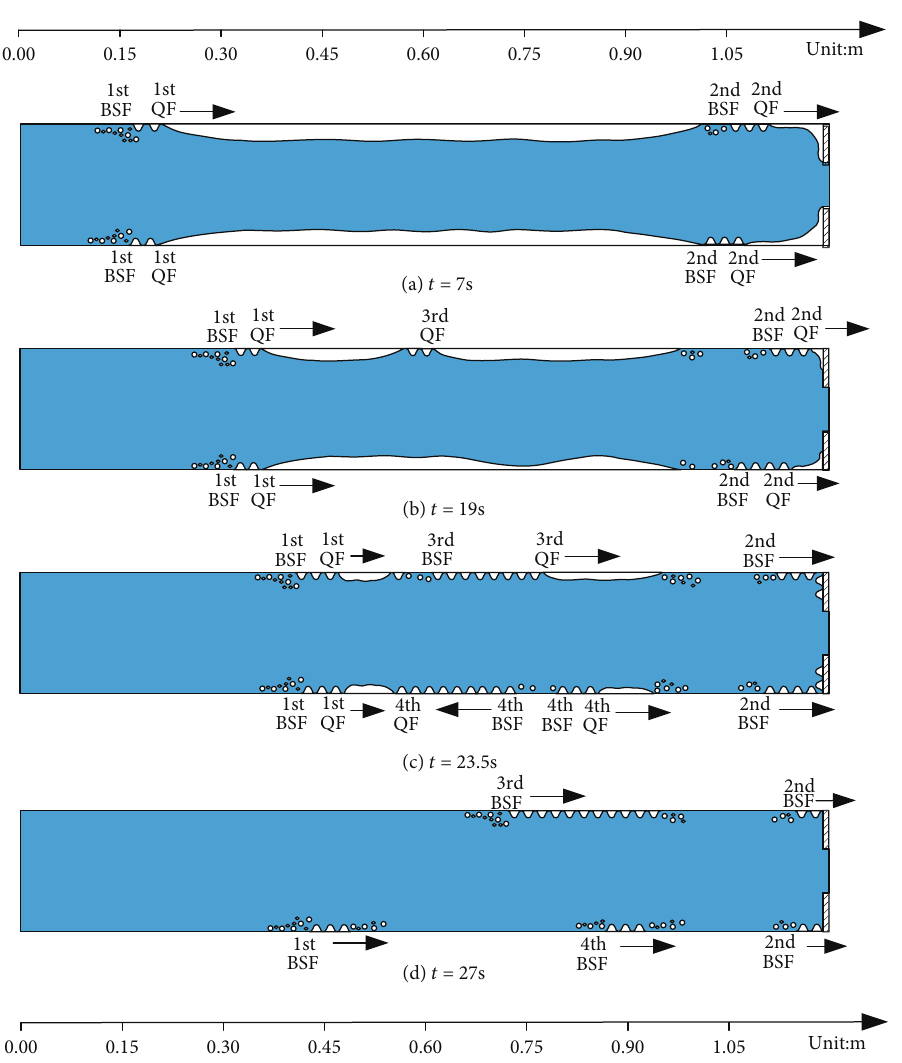
Figure 4: Flow patterns in the experimental section during the chill-down process for Exp.